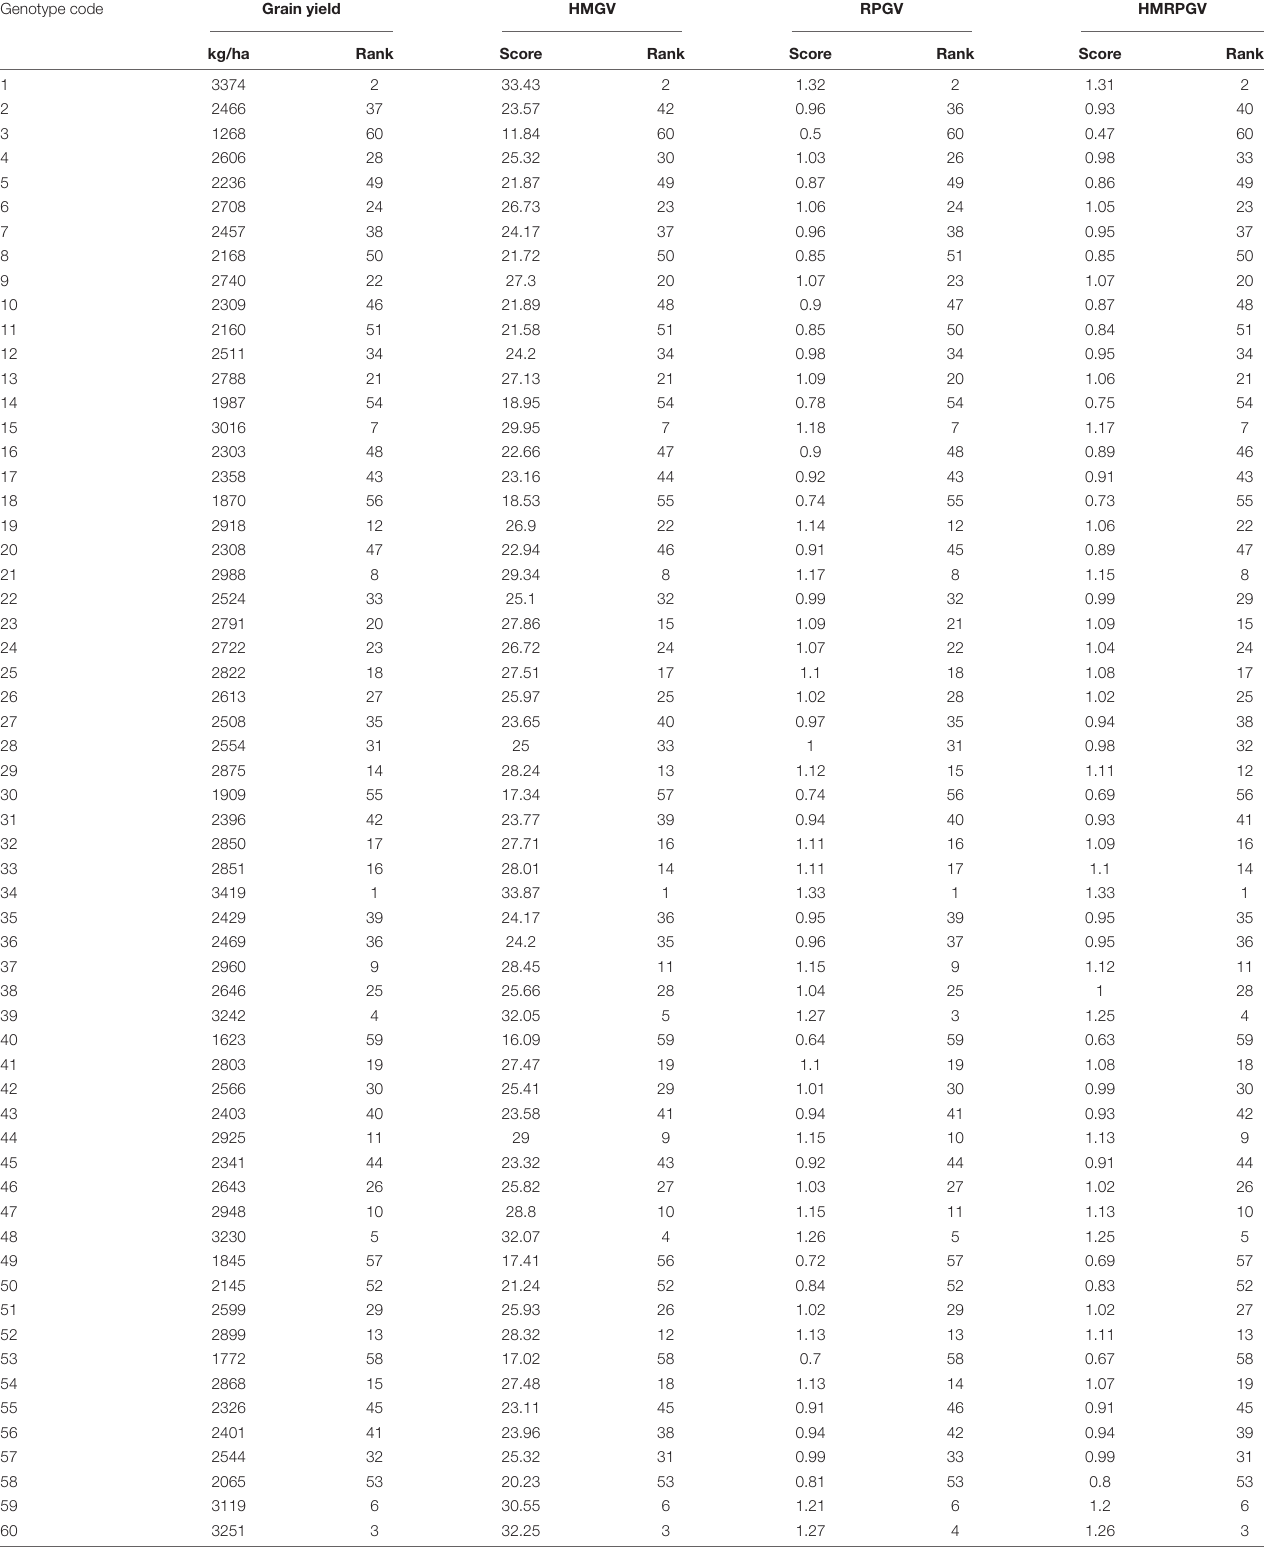
TABLE 5 | BLUP-based ranking of 60 finger millet genotypes evaluated under six environments during the main seasons of 2011–2016. Genotype